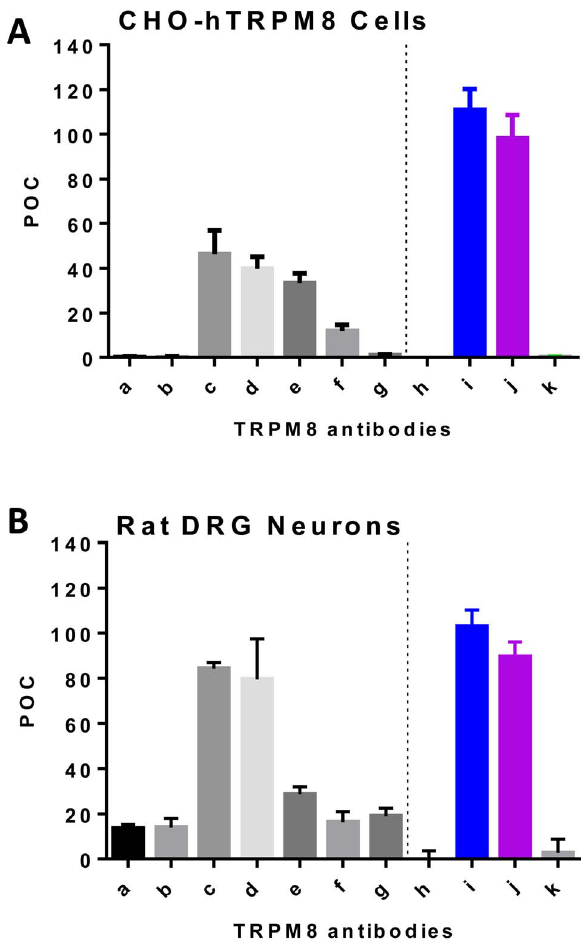
Figure 6. Icilin activation of TRPM8 in CHO cells and rat DRG neurons. Antagonism of icilin induced activation of human TRPM8 recombinantly expressed by CHO cells (A) and rat DRG neurons (B) by additional poly- and monoclonal antibodies generated against the third extracellular pore loop. a . Alomone ACC-049. b . MyBiosource MBS609041. c . Creative Diagnostics CABT37242RH. d. Thermo Scientific OST00133W. e . Antibodies Online ABIN351226. f . Lifespan Biosciences LS-B6668. g . Enzo Lifesciences BML-SA664. h . M8-B. i . 1 m M icilin. j . 1 m M icilin + peptide (SDVD GTTYDFAHC). k . Buffer. A. Note the complete block of TRPM8 channel activation by ACC-049 ( a